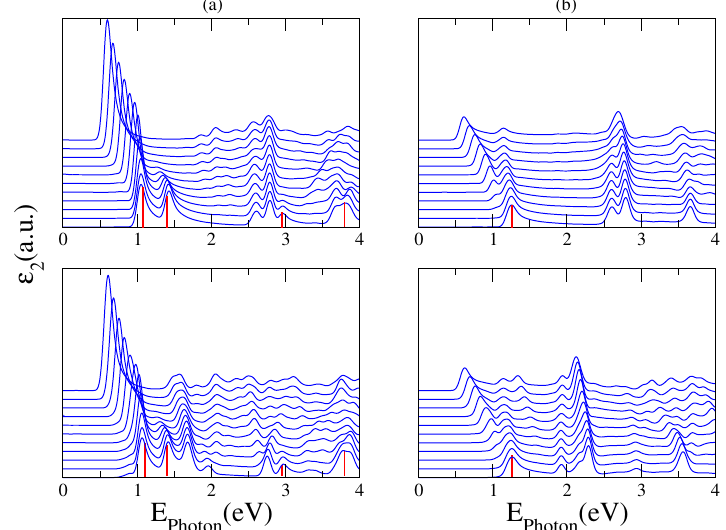
Figure 8. Imaginary part of the dielectric constant for a 10GR–C 60 (upper panel) and a 10GR–C 70 (lower panel) system for incident light linearly polarized ( a ) parallel to the ribbon and ( b ) perpendicular to the ribbon. The curves correspond to electric field intensities from 0.0 to 1.0 V/Å, vertically shifted for clarity. The red line shows the position of the optical absorption peaks of the pristine